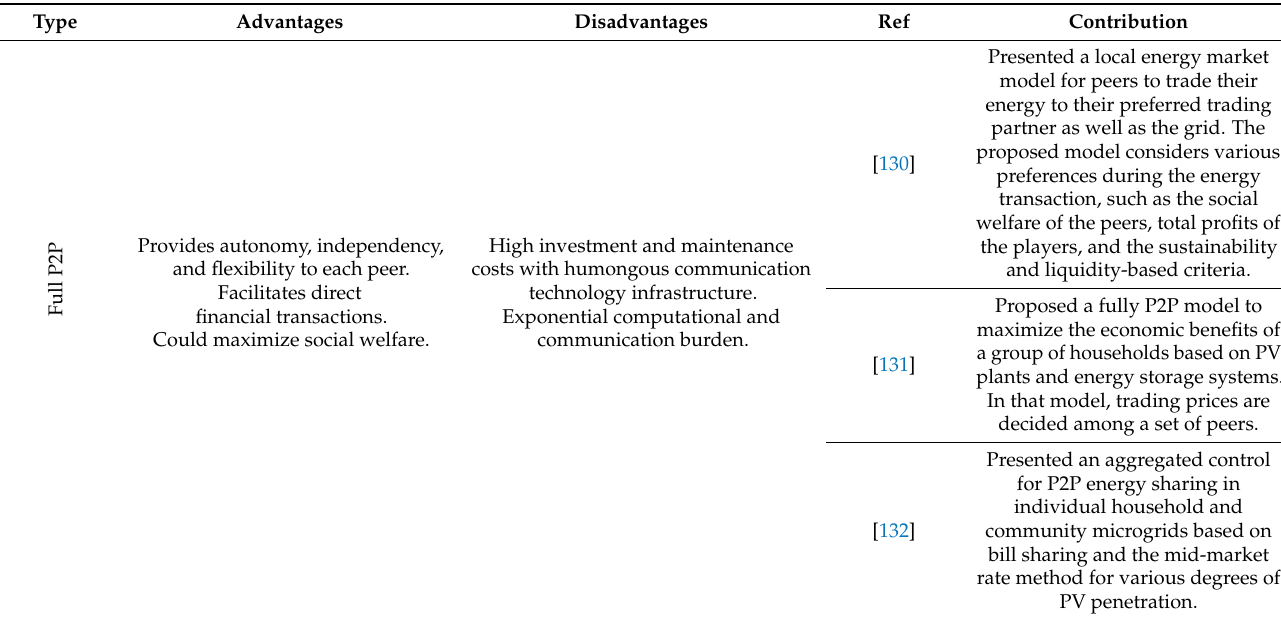
Table 4. Summary of energy trading mechanism for the P2P energy market.